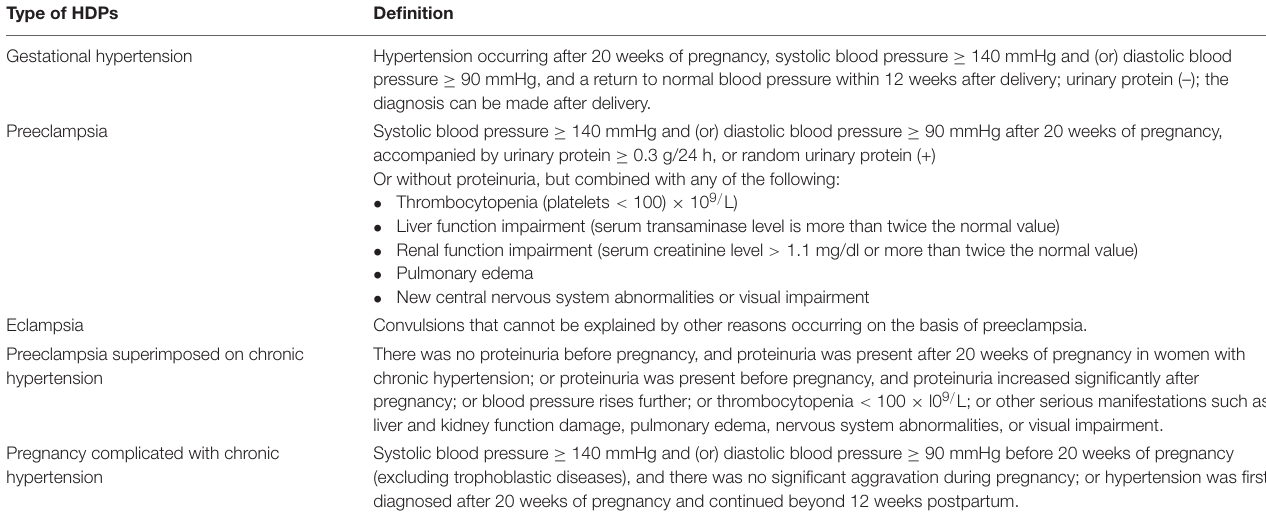
TABLE 1 | Definition of